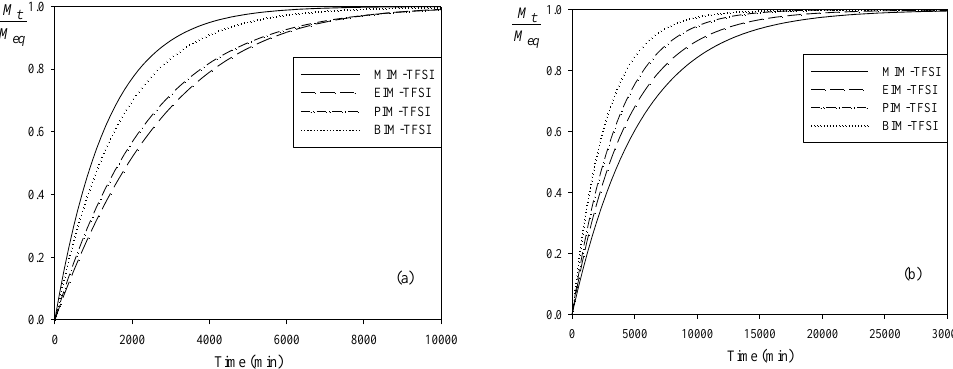
Figure 5. Influence of the RH value on the water uptake for studied PILs at 25 ± 1 °C: ( a ) 70% RH, ( b ) 94% RH.